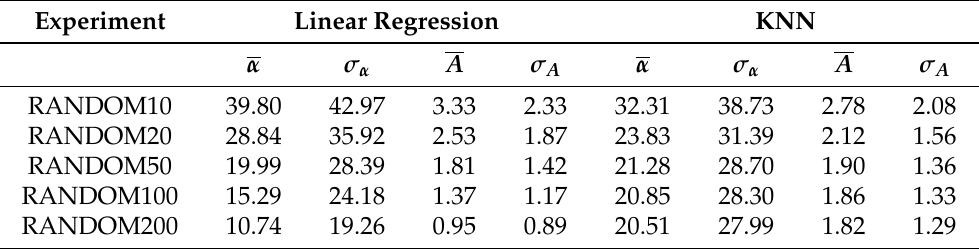
Table 3. Table showing reconstruction error measured as average angular and amplitude error ( α and A ) and its standard deviation ( σ α and A ) for linear regression and KNN with random selection of sensor locations (dummy algorithm). Amplitude is given in m/s, angle in degrees.